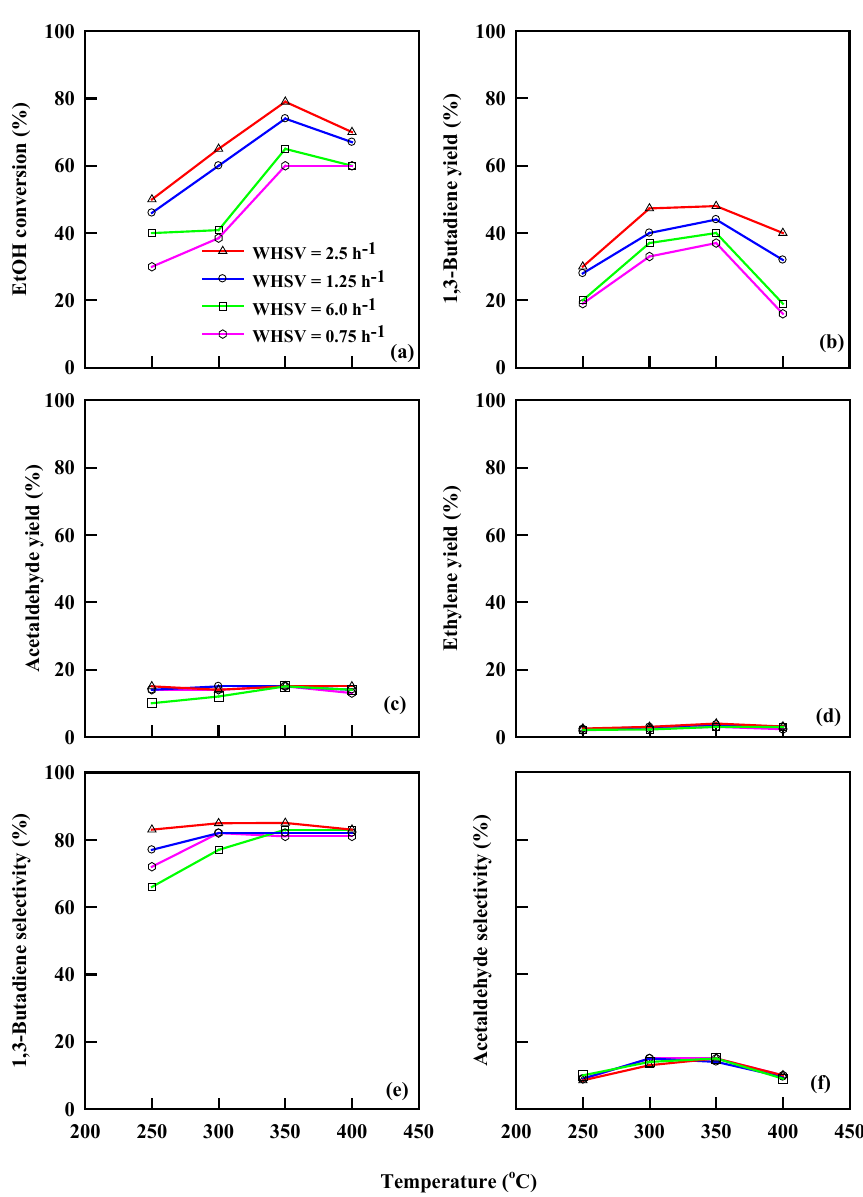
Figure 7. Plot of the Ash:MgO (1:2) catalyst ( a ) ethanol conversion, ( b ) yield of 1,3-butaiene ( c ) acetaldehyde yield ( d ) ethylene yield ( e ) 1,3-butadiene selectivity and ( f ) acetaldehyde selectivity at different reaction temperatures and WHSV. Catalyst: 0.4 g, WHSV = 0.75–6.0 h −1 , N 2 : 30 mL/min